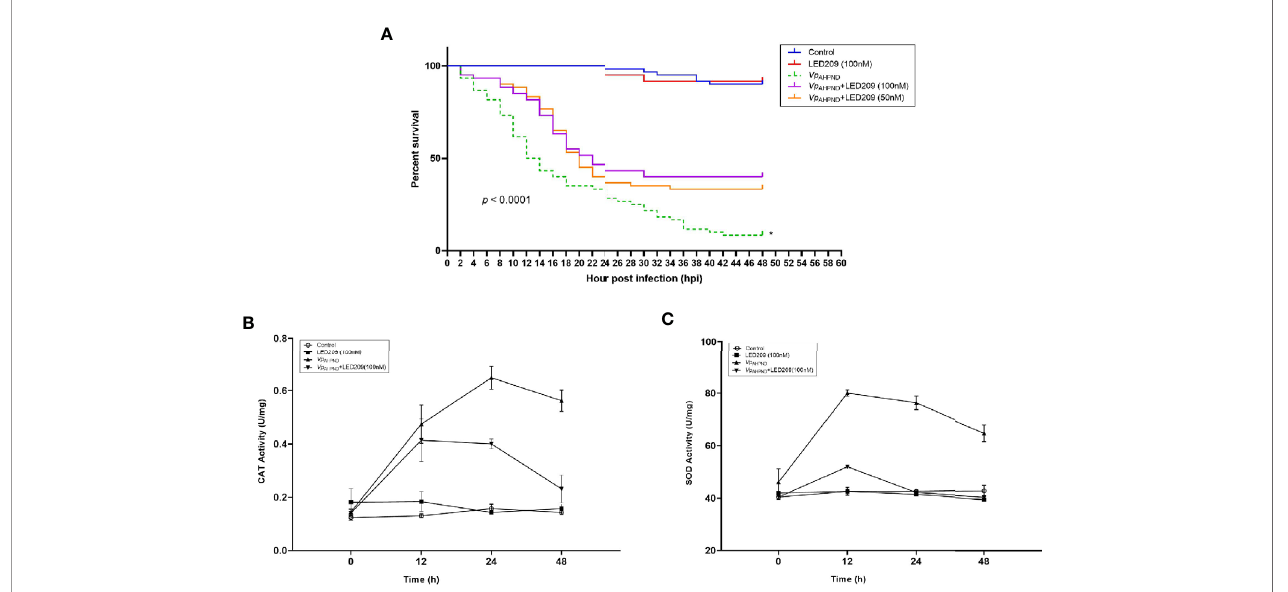
FIGURE 5 | Dynamics of mortalities and temporal activities of the immune-related enzymes after Vp AHPND challenge. (A) Treatment of LED209 protects white shrimp ( Penaeus vannamei ) from Vp AHPND infection. LED209 was used at 50 and 100 nM, respectively. The survival curves were recorded for 48 h after challenge, p < 0.0001 based on Kaplan-Meier survival analysis with a log rank test with Prism software (Graphpad Software). (B) Superoxide dismutase (SOD) activity. (C) Catalase (CAT) activity. Data were presented as mean ± standard deviation (SD) of three independent experiments. (*Note: the survival curve data of Vp AHPND 123 without treatment have been published in another article by the author (Yang et al., 2020, (J) Appl. Microbiol.), and the relevant data were obtained from the same batch of